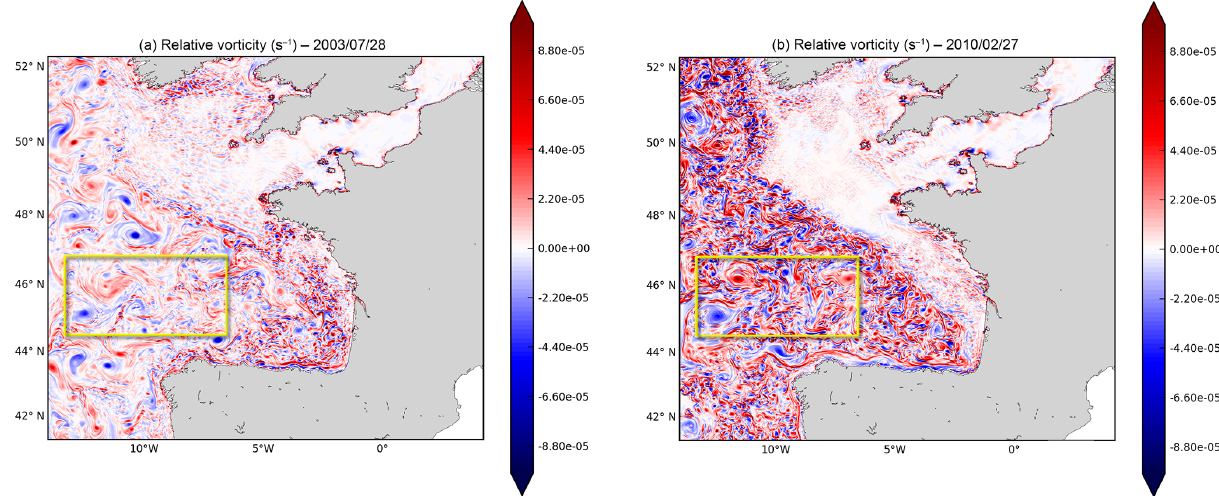
Figure 9. Surface modelled relative vorticity for 28 July 2003 (a) and 27 February 2010 (b) . The yellow rectangle limits the targeted region for